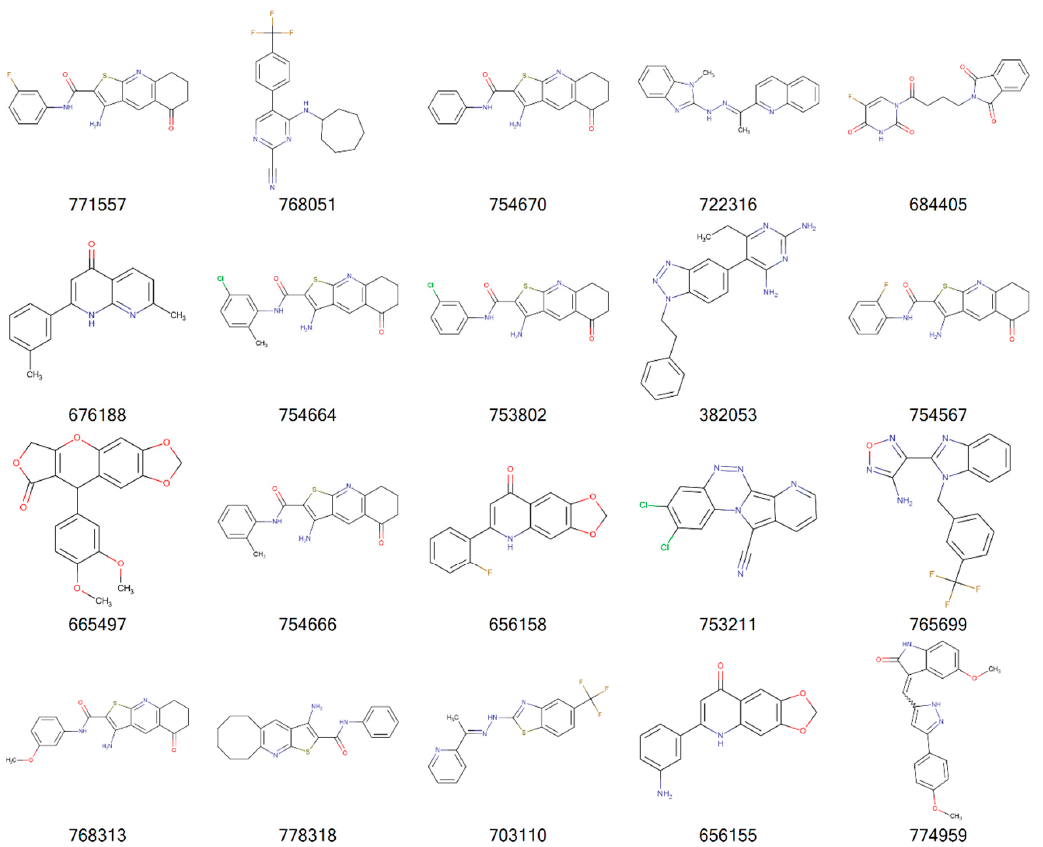
Figure 5. 2D structures of top 20 drug-like ligands for colon cancer. Listed are NSC-771557, NSC- 768051, NSC-754670, NSC-722316, NSC-684405, NSC-676188, NSC-754664, NSC-753802, NSC-382053, NSC-754567, NSC-665497, NSC-754666, NSC-656158, NSC-753211, NSC-765699, NSC-768313, NSC- 778318, NSC-703110, NSC-656155, and NSC-774959.